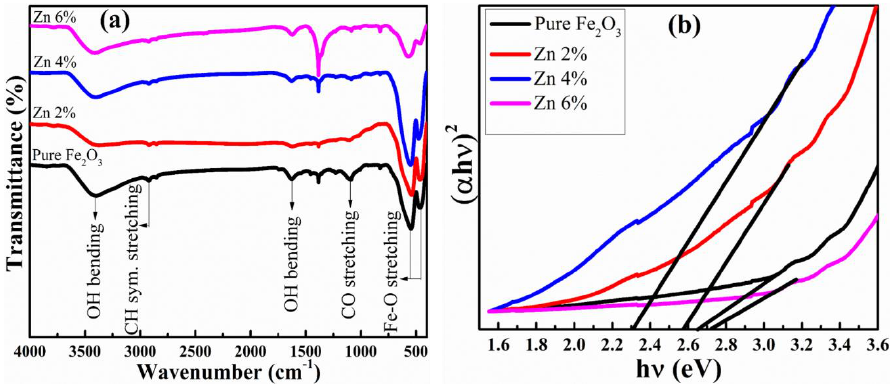
Figure 5. ( a ) FTIR transmittance (%) spectra and ( b ) Tauc plot of pure Fe 2 O 3 , Zn 2%, Zn 4% and Zn 6% nanoparticles.